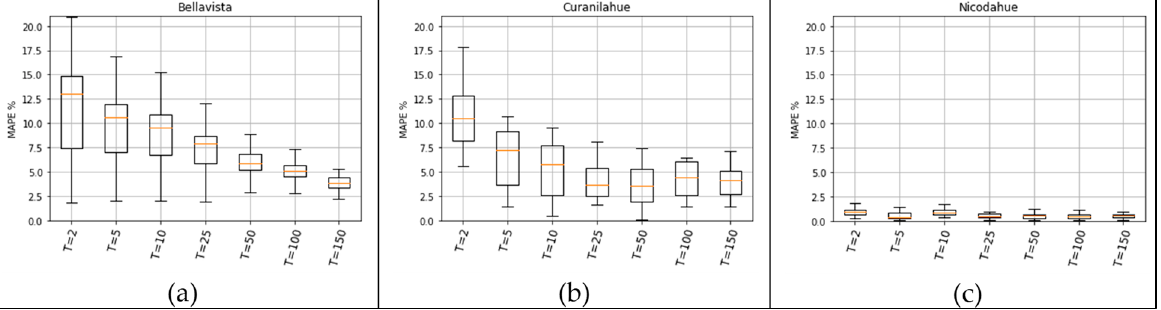
Figure 5. Boxplots of the absolute percentage differences in depth between HM-T and HM-RS at different return periods for the ( a ) Bellavista, ( b ) Curanilahue, and ( c ) Nicodahue